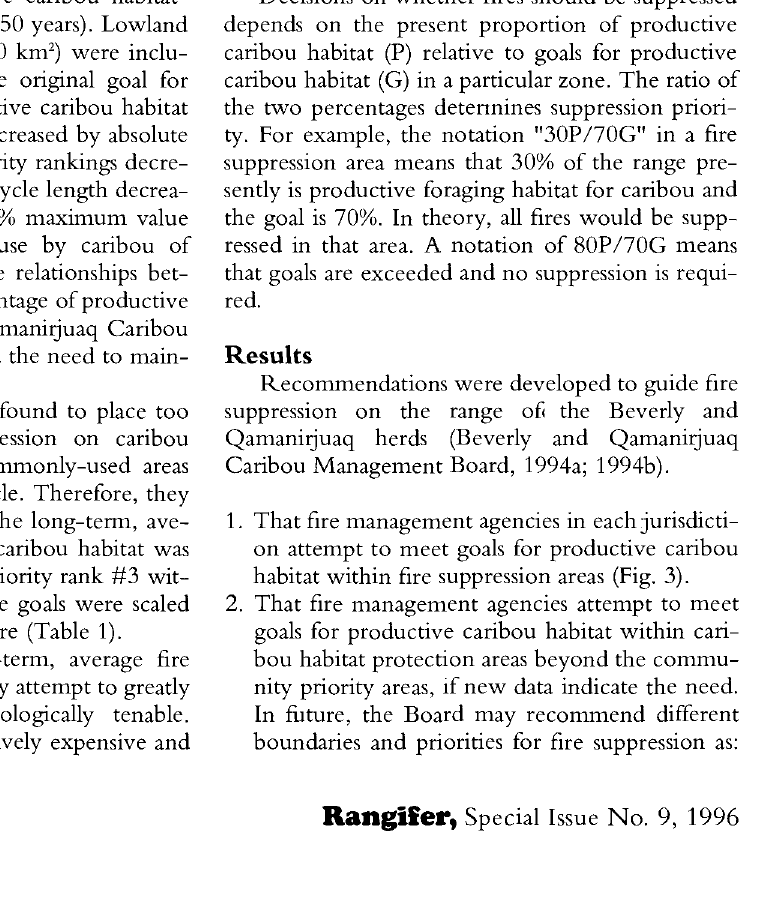
Fig. 2. Fire cycle lengths on the forested range of the Beverly and Qamanirjuaq herds of caribou as esti mated from fire statistics and observed fire return intervals.